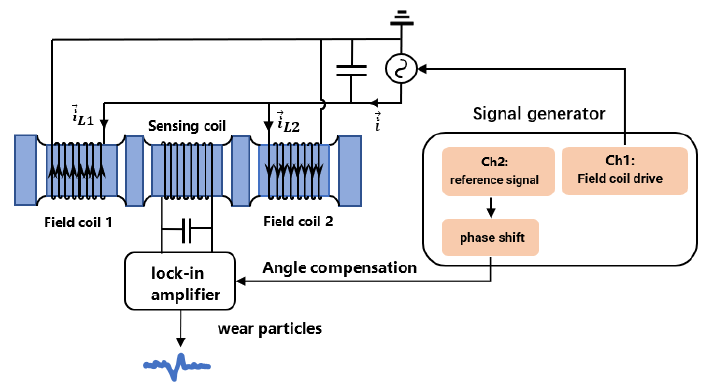
Figure 7. Schematic diagram of the test platform.